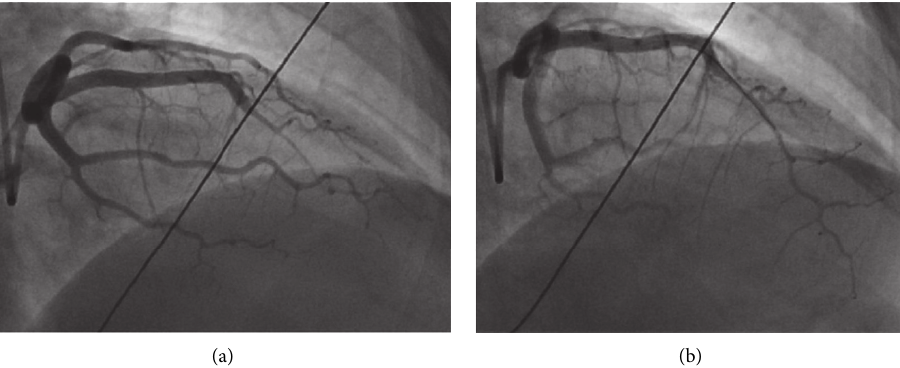
Figure 2: (a) Type 2B SCAD of the mid to apical LAD. (b) Partial successful PCI of the mid to apical LAD with final TIMI 3 flow.